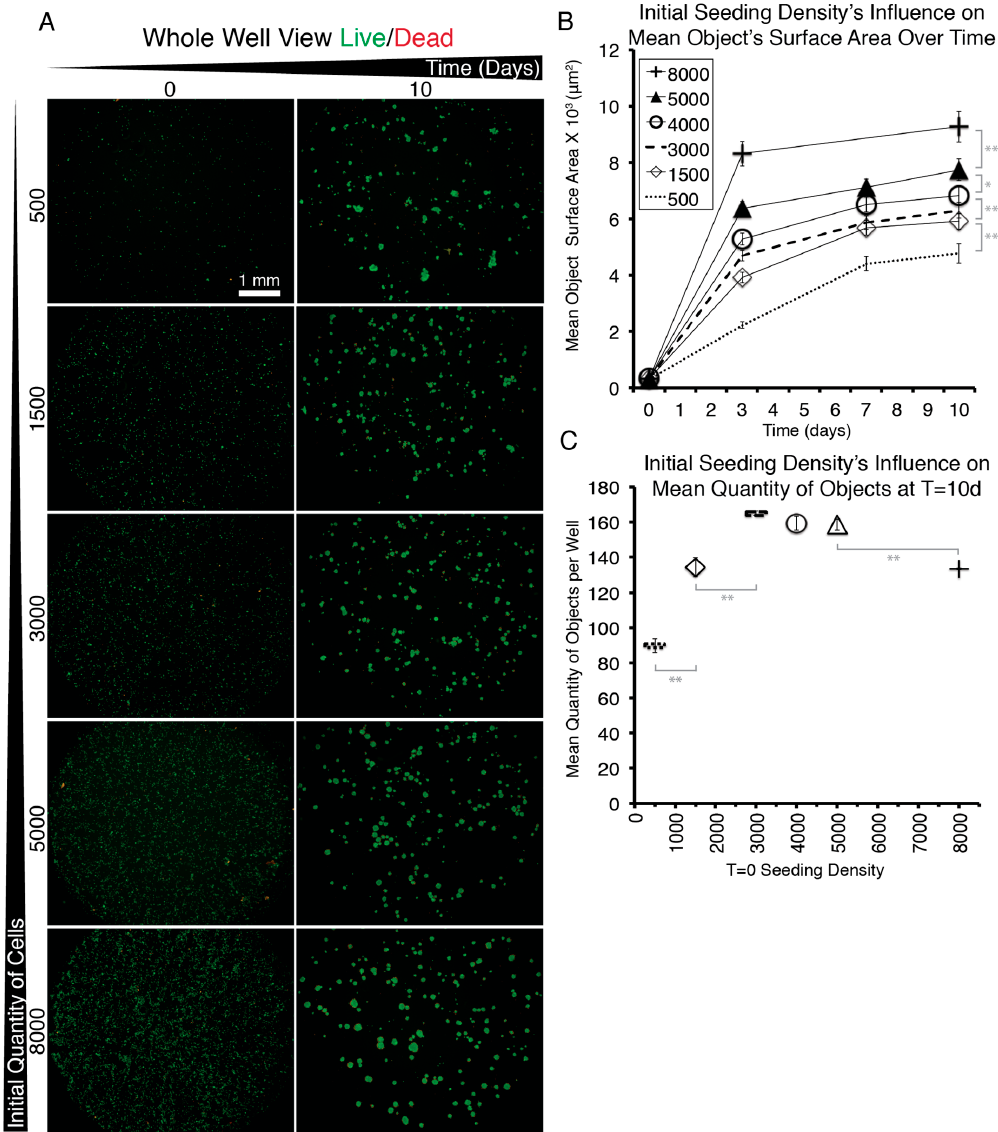
Figure A7. Images of Entire Wells From a 96 Well Plates Showing NS-SV-AC Cells Stained with Live/Dead and Graphs to Demonstrate How seeding Density Affects Sphere Quantity and Size. ( A ) Images captured with 2X objective at T = 0 and T = 10 days. ( B ) Quantification of the Calcein AM positive objects in the wells and measurements of their mean surface area. ( C ) Quantification of the total number of Calcein AM positive objects detectable per well as a function of seeding density. Error Bars = Standard Error. For statistical analysis (grey lines) one-way ANOVA followed by Tukey’s Post-Hoc test with p -values = * <0.05, ** < 0.01 was used.